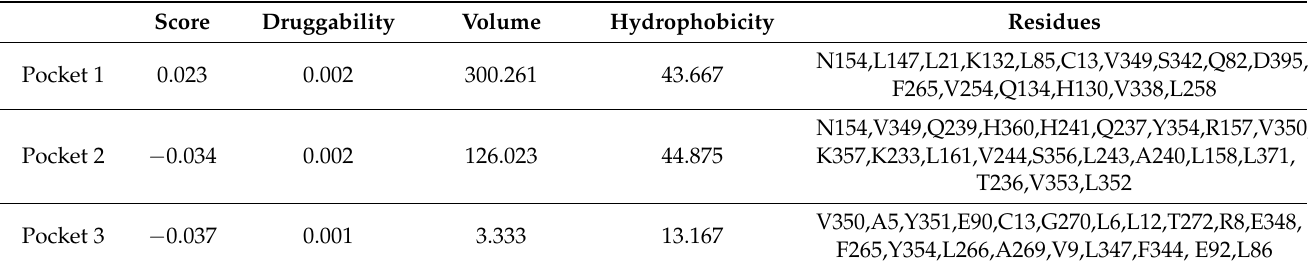
Table 1. Allosteric site descriptors of APOL1 allosteric